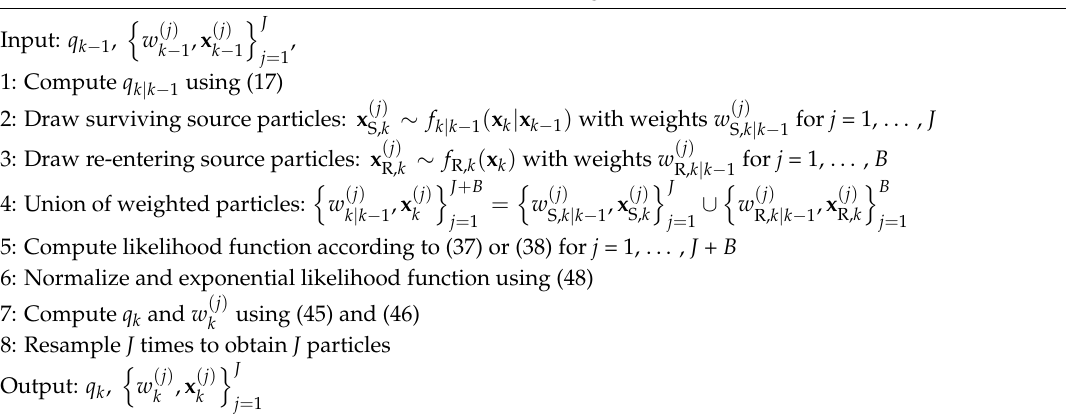
Algorithm 1. Bernoulli filter for detection and DOA